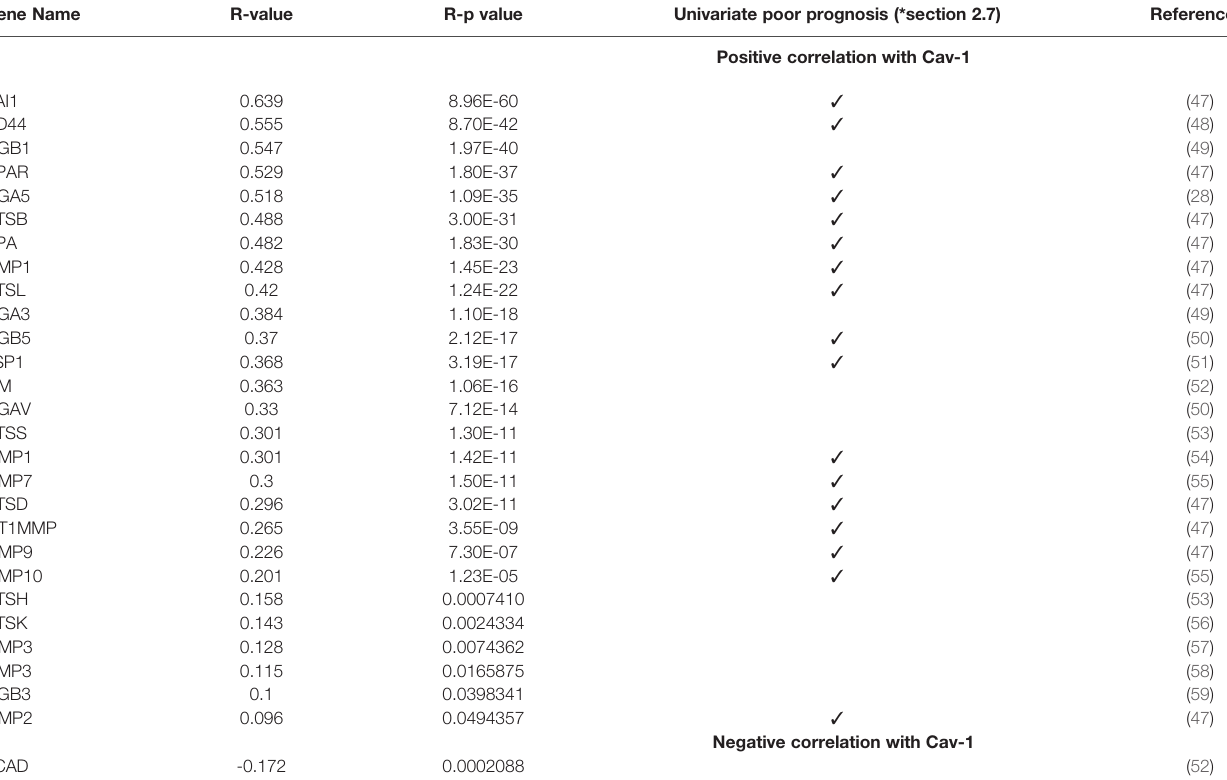
TABLE 2 | Correlation analysis in GB of Cav-1 and genes (identi fi ed from the pathway analysis) related to cell adhesion, ECM organisation and EMT